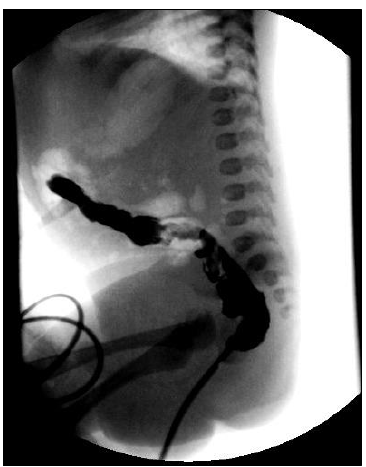
Figure 2: Contrast study showing rectoscrotal fistula, in- termediate level of ARM and close proximity with the ure- thral